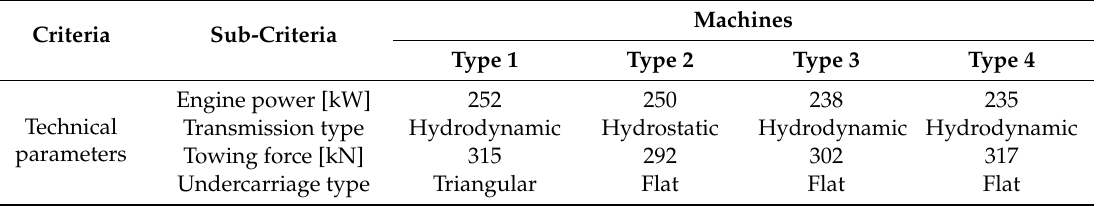
Table 4. Input parameters for applying the AHP method for technical parameters.